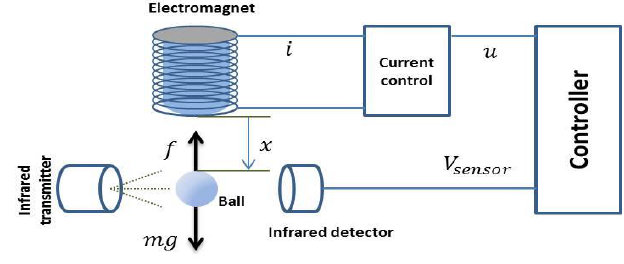
Fig. 1. Schematic of a simple magnetic levitation system